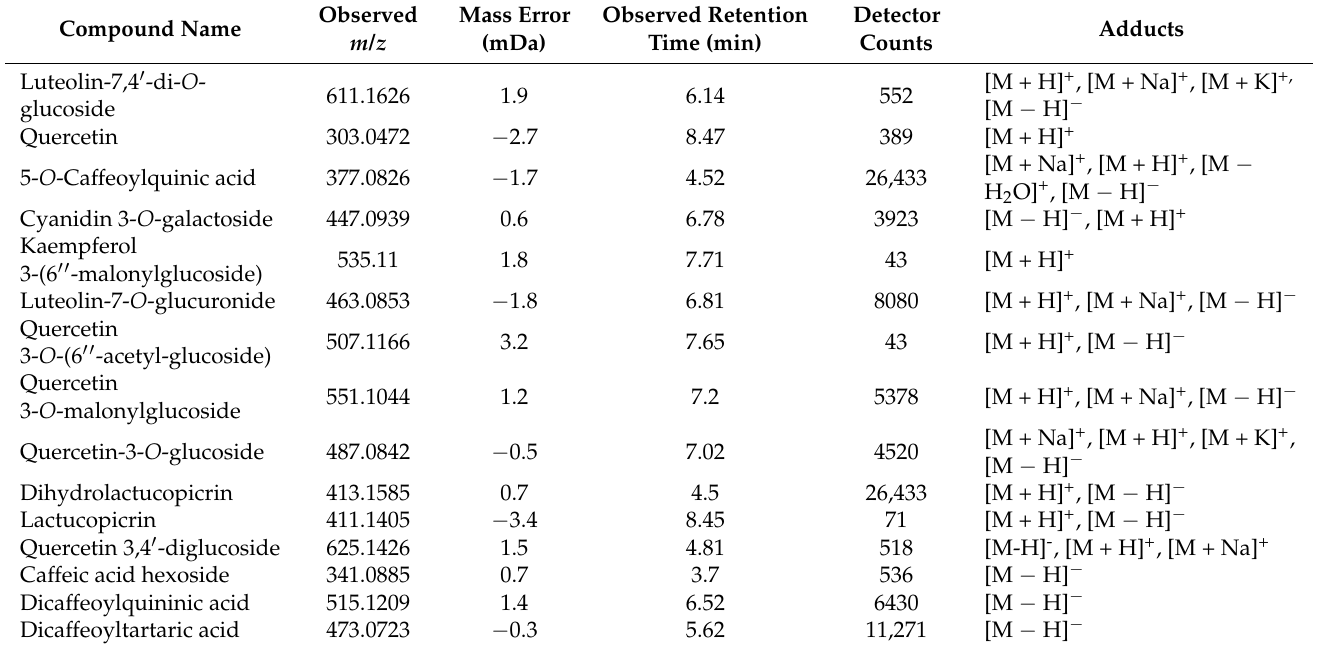
Table 1. Tentative identification of the metabolites in green and red multi-leaf lettuce grown under Se and S treatment using